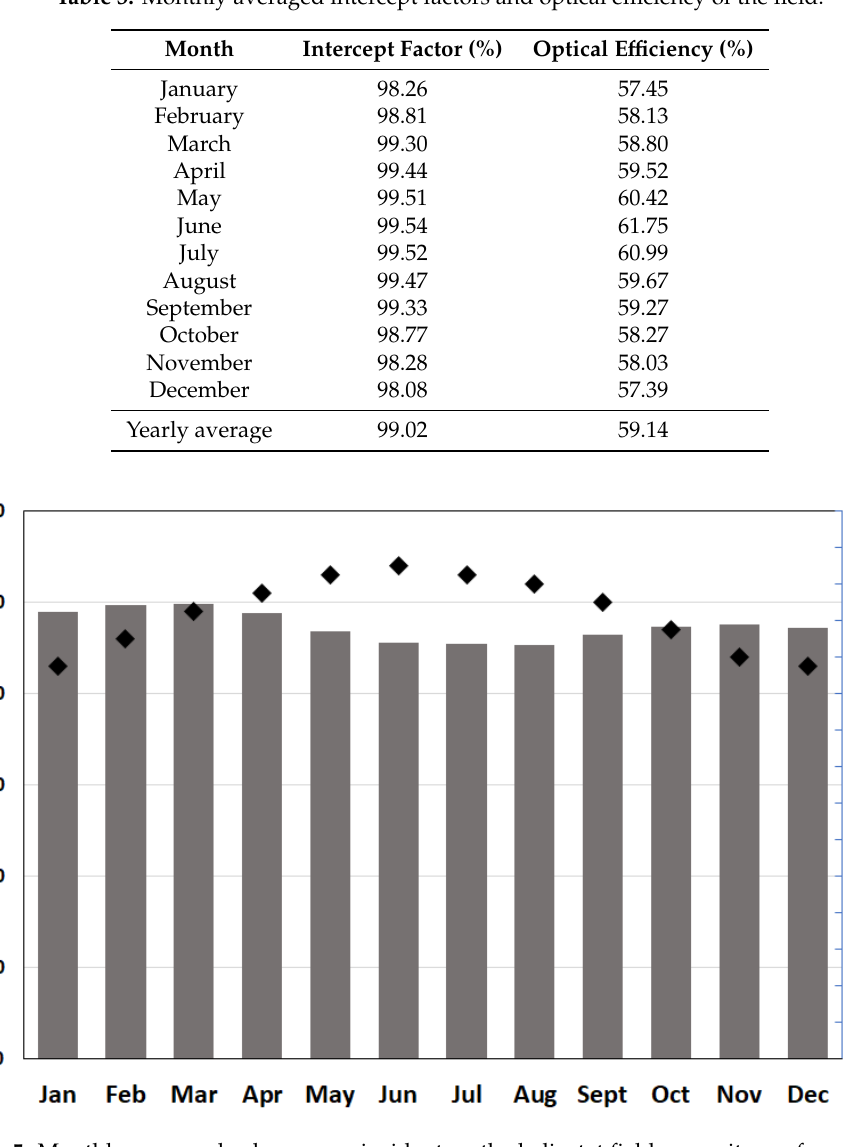
Figure 5. Monthly averaged solar energy incident on the heliostat field per unit area from 8 a.m. to 4 p.m. Dots represent daylight availability in hours.